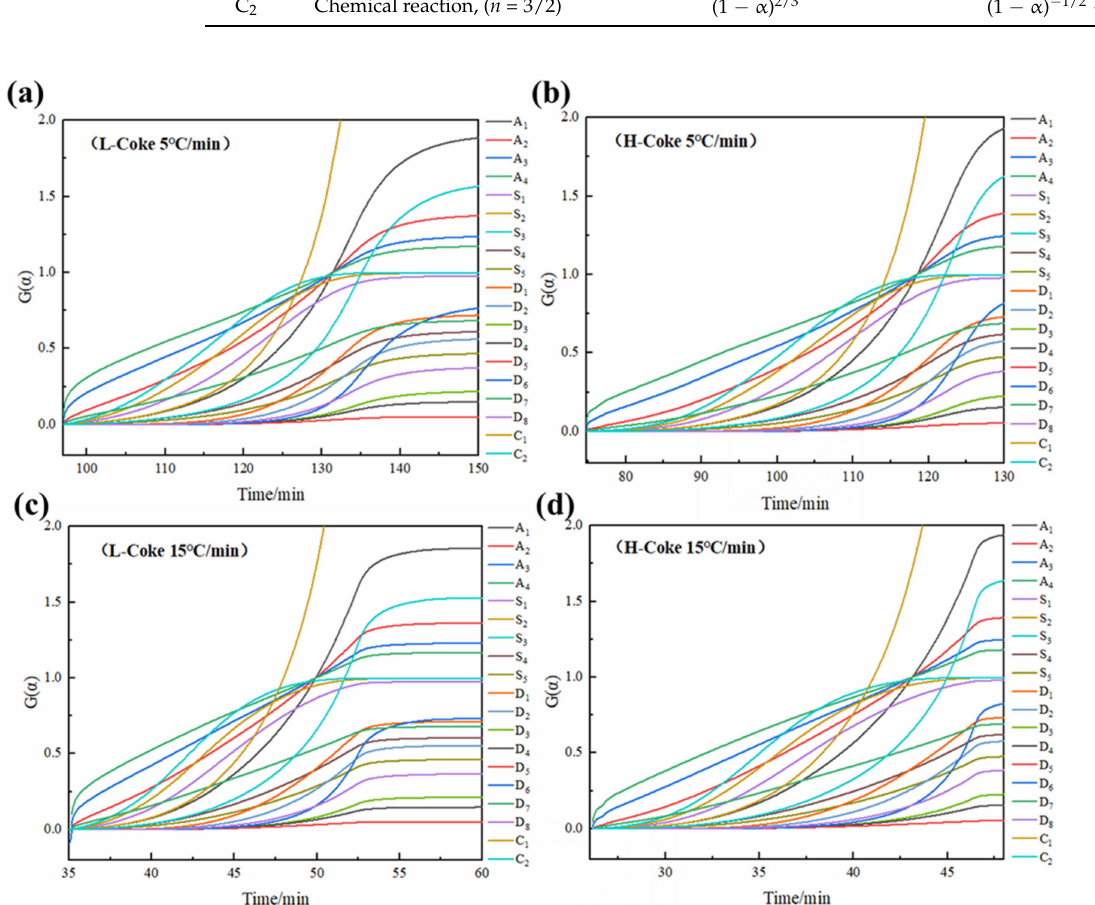
Figure 4. Kinetic models of coke combustion reactions at 5 ◦ C/min and 15 ◦ C/min ( a ) is the L-Coke combustion at 5 ◦ C/min, ( b ) is the H-Coke combustion at 5 ◦ C/min, ( c ) is the L-Coke combustion at 15 ◦ C/min, ( d ) is the H-Coke combustion at 15 ◦